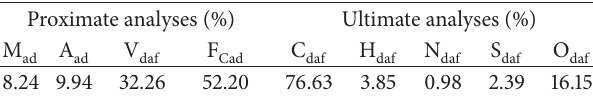
Table 1: Proximate and ultimate analyses of coal sample. Proximate analyses (%) Ultimate analyses